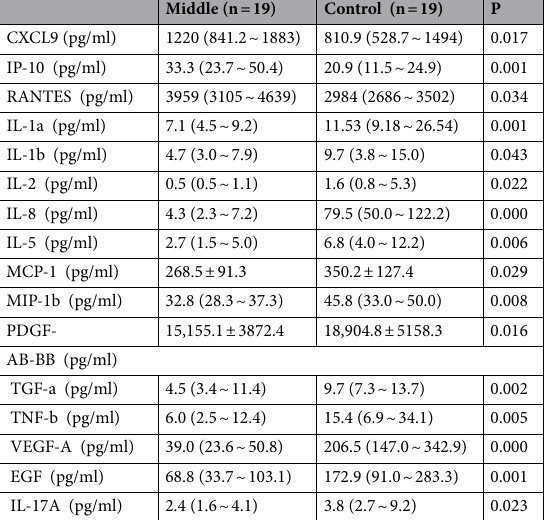
Table 2. Serum levels of cytokines between UPA and control groups. P < 0.05 was considered significant.